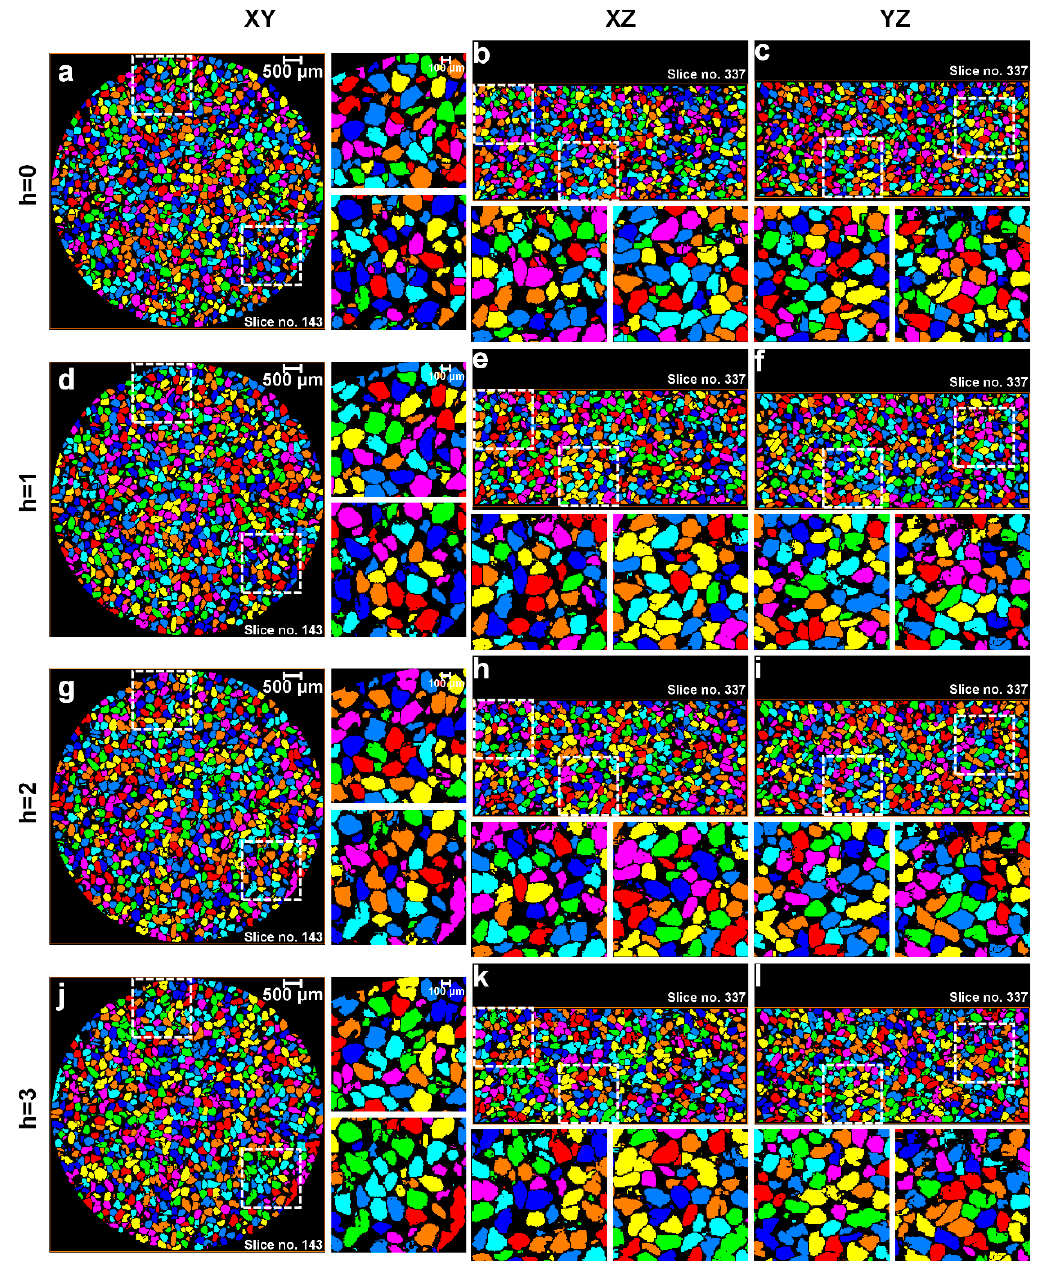
Figure 13. Separation outcomes (XY, XZ, and YZ views through the centre of the sand volumes) for